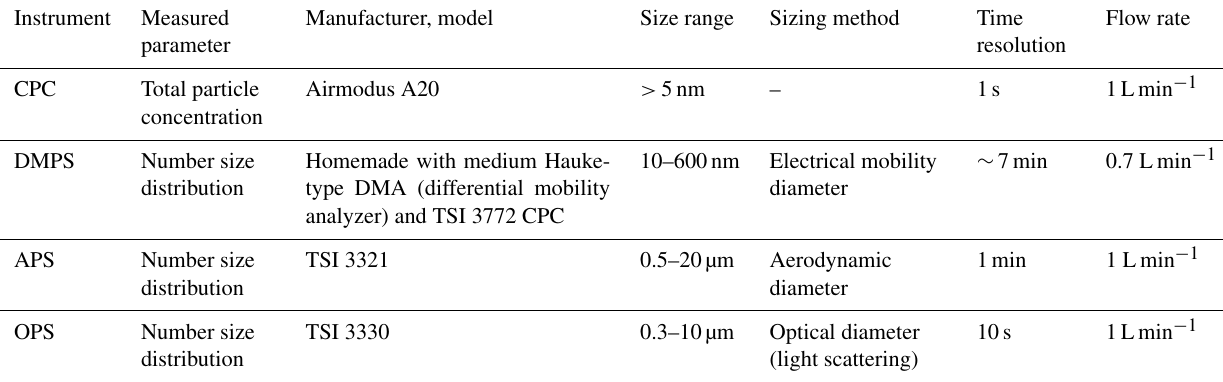
Table 1. Particle counters and their specifications used in the experiment. Flow rate refers to sampling flow rate of the devices.